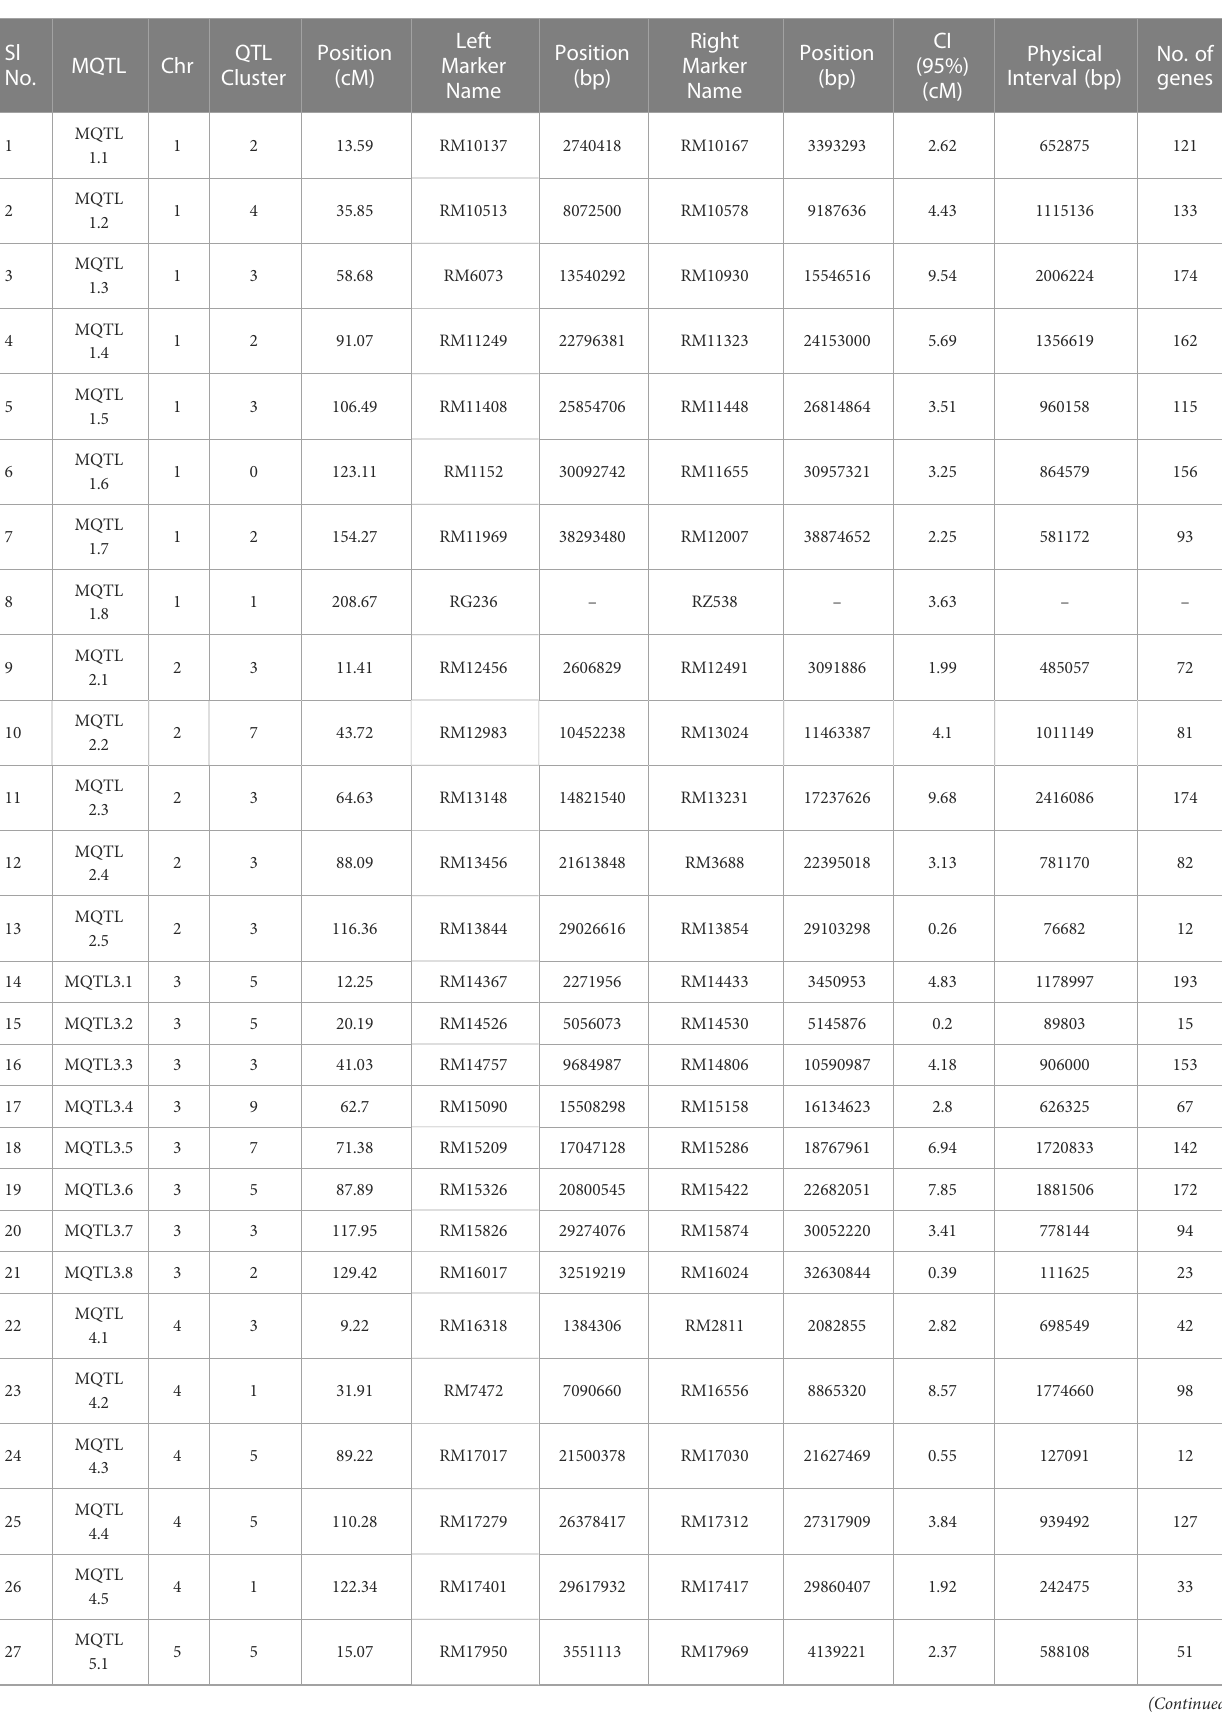
TABLE 2 Summary of the detected meta-QTLs for grain chalkiness in rice.